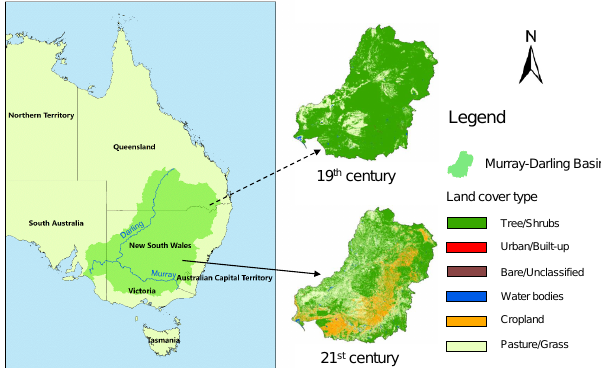
Figure 1. Location map and land cover changes of the Murray– Darling